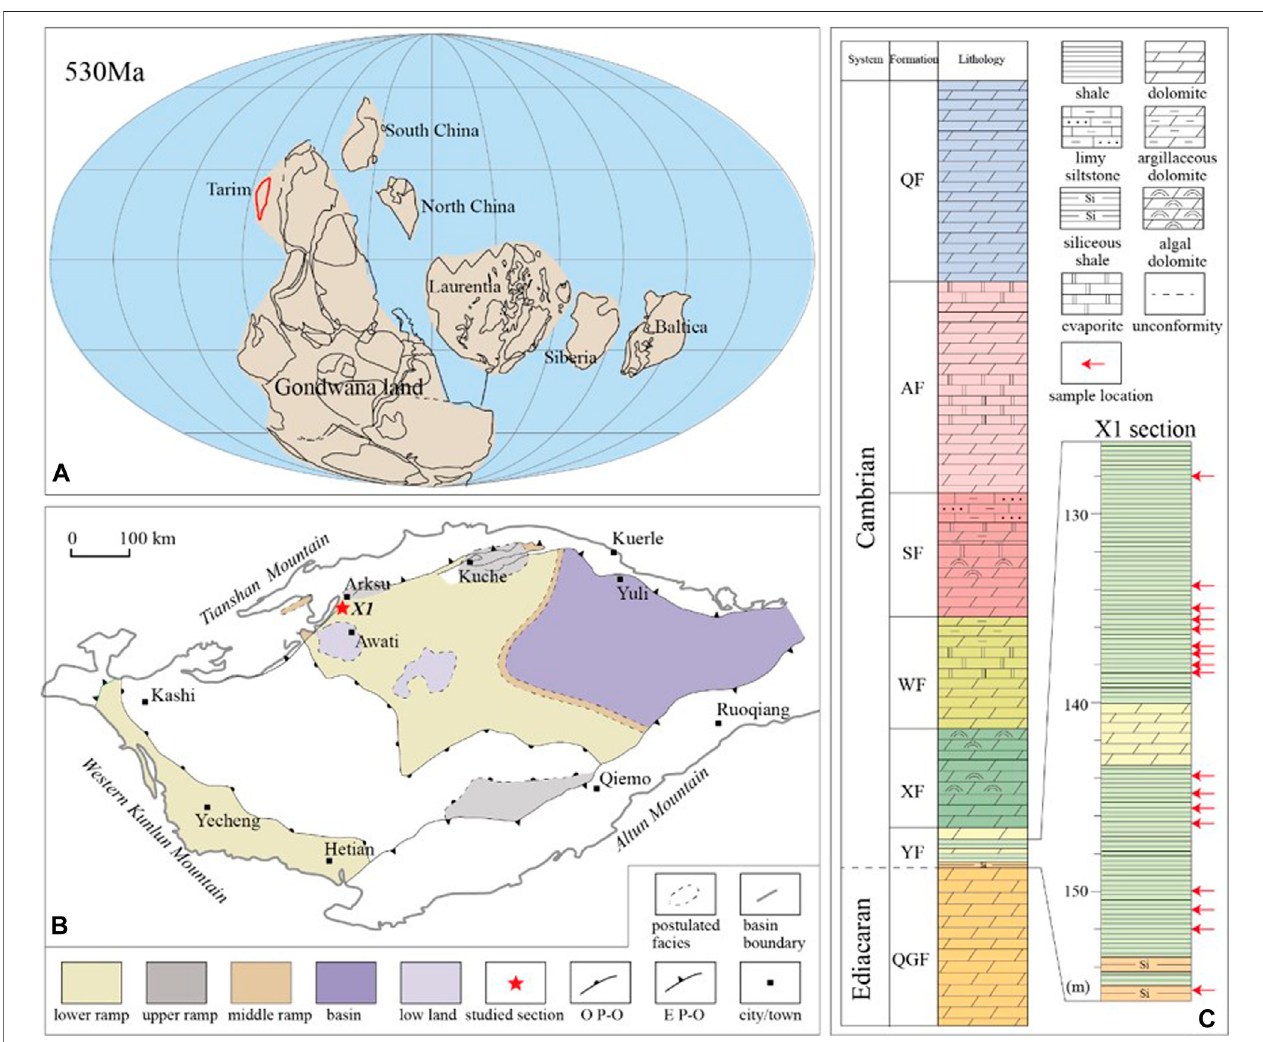
FIGURE1|(A) PaleogeographicmapoftheTarimBlockduringtheearlyCambrian(530 Ma)[modi fi edfromLietal.(2008)]. (B) Sedimentaryfaciesmapoftheearly Cambrian Yurtus Formation of the Tarim Block [modi fi ed from Du and Pan (2016)] and the location of drill core XK1. O P-O (cid:1) Overlapping pinch-out line of the Yurtus Formation, E P-O (cid:1) Erosional pinch-out line of the Cambrian strata. (C) Stratigraphic column of the Cambrian strata in the Tarim Block [modi fi ed from Zhu et al. (2018)] and the Yurtus Formation of XK1 drill core. Red arrows indicate the stratigraphic location of samples. QGF (cid:1) Qigeblak, YF (cid:1) Yurtus, XF (cid:1) Xiaoerblak, WF (cid:1) Wusongger, SF (cid:1) Shayilike, AF (cid:1) Awatage, QF (cid:1) Qiulitage. The depth values are relative to the top of the drill core.